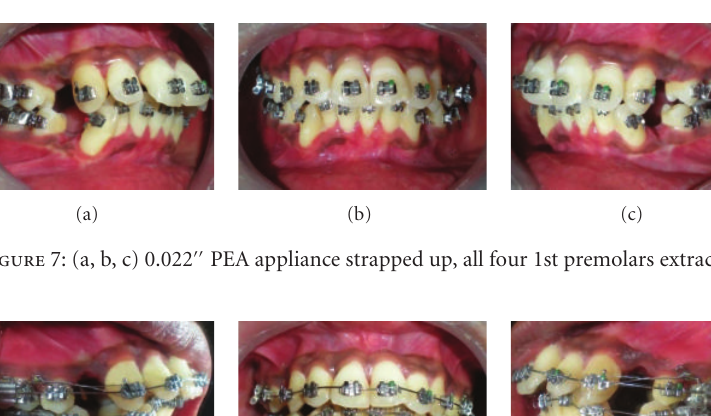
(Figure 7). In maxilla, miniscrews [18] (1.5 mm